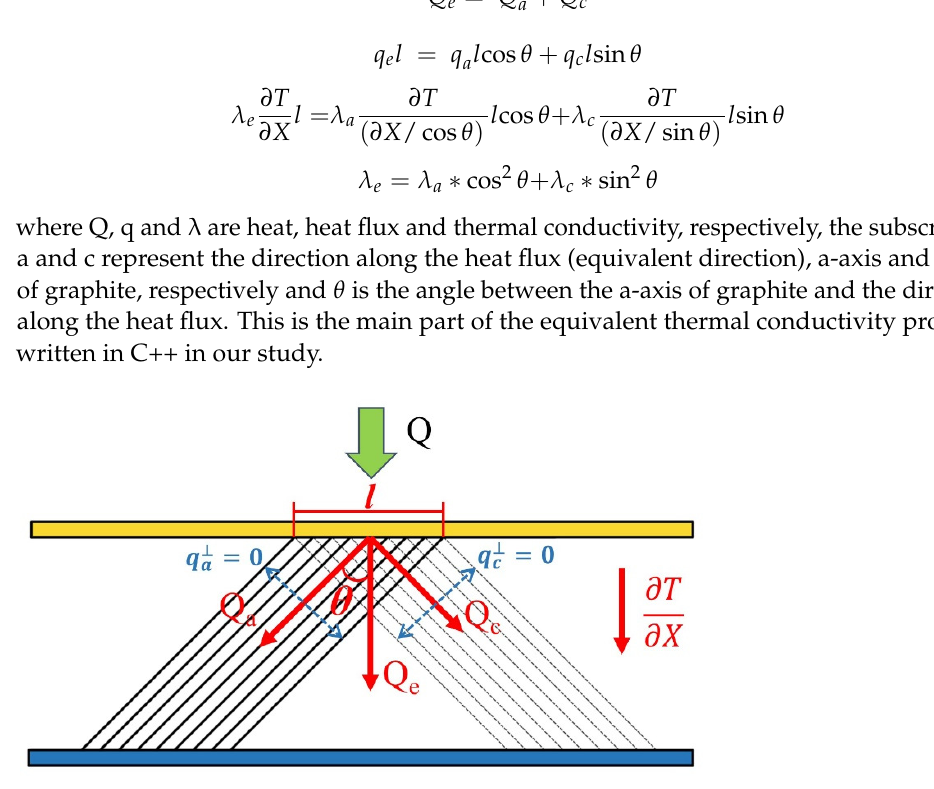
Figure 2. Conversion of non-main direction thermal conductivity of graphite under the one-dimensional steady heat transfer.